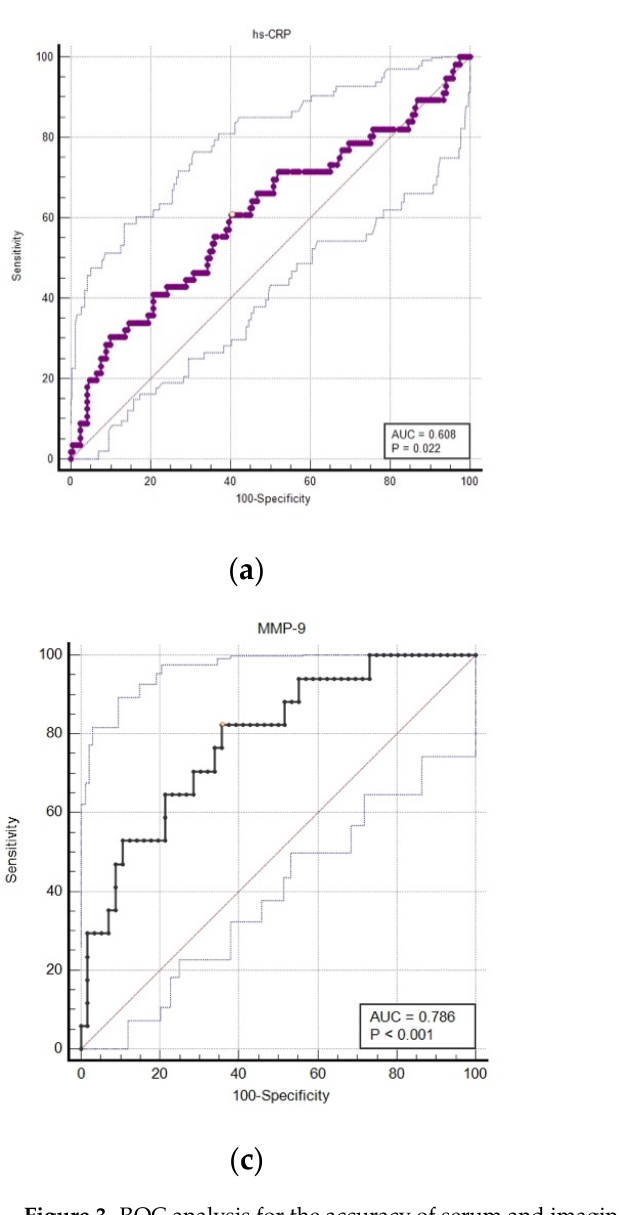
Figure 3. ROC analysis for the accuracy of serum and imaging markers in predicting 1 year MACE in patients with AMI. ( a ) ROC curve for hs-CRP in predicting MACE; ( b ) ROC curve for I-CAM in predicting MACE; ( c ) ROC curve for MMP-9 in predicting MACE; ( d ) ROC curve for LVEF% in predicting MACE.